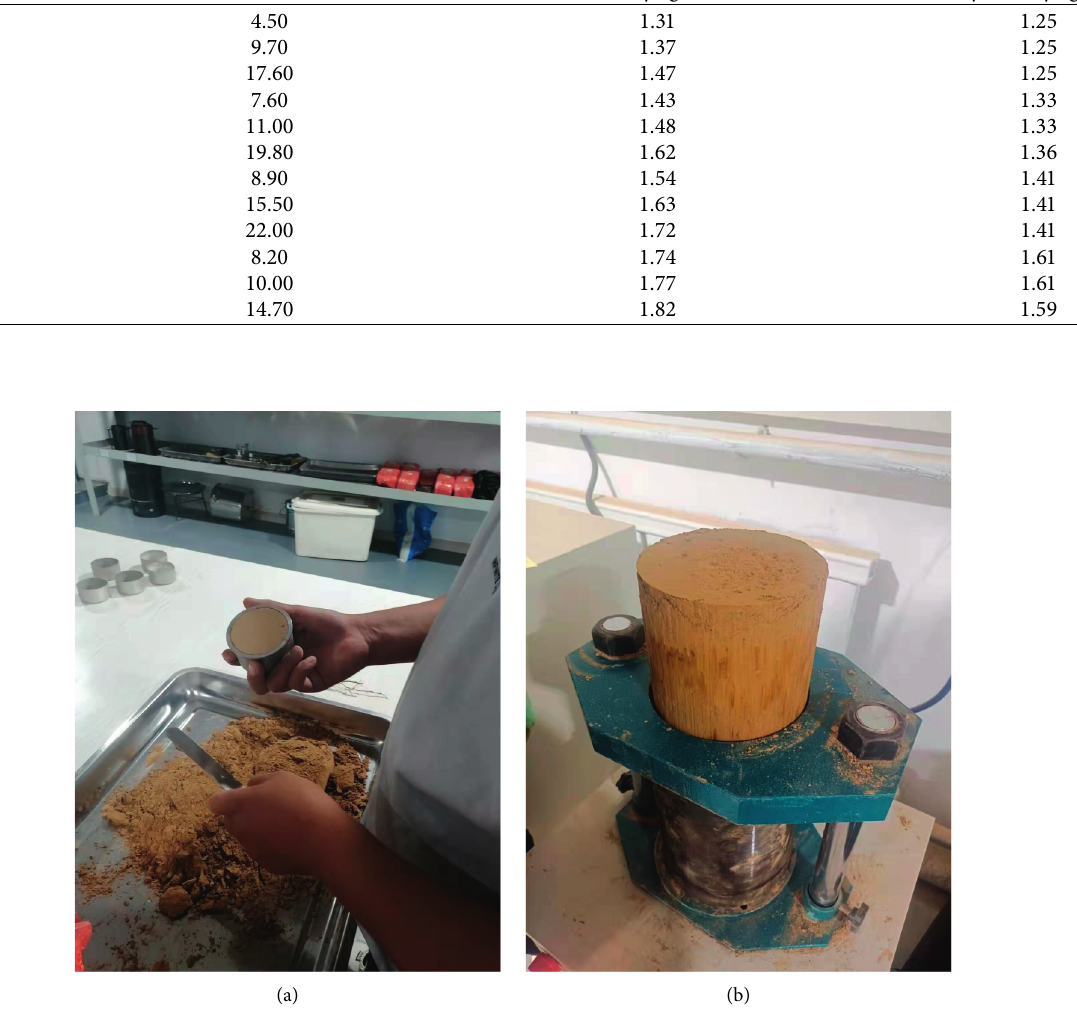
Figure 4: Permeability test specimens. (a) The intact soil specimens. (b) The remolded soil